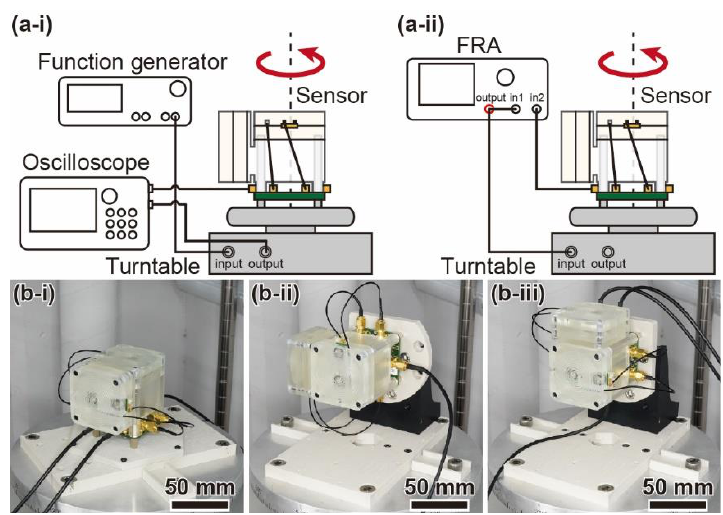
Figure 8. Measurement of the sensor response. ( a ) Schematic image of the experimental configura- tions to evaluate ( i ) the output waveforms and ( ii ) the frequency response to angular acceleration. ( b ) Photographs of the experimental setups when the angular acceleration around each axis is applied. ( i ) z -axis, ( ii ) x -axis, and ( iii ) y